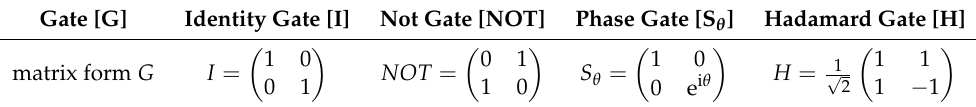
Table 2. Four basic quantum gates for one-qubit systems; the gates [I] and [NOT] also denoted [X] are associated with the Pauli matrices σ 0 or I and σ 1 or σ x , respectively; the two other Pauli matrices σ 2 or σ y and σ 3 or σ z define two further one-qubit gates denoted as [Y] and [Z],